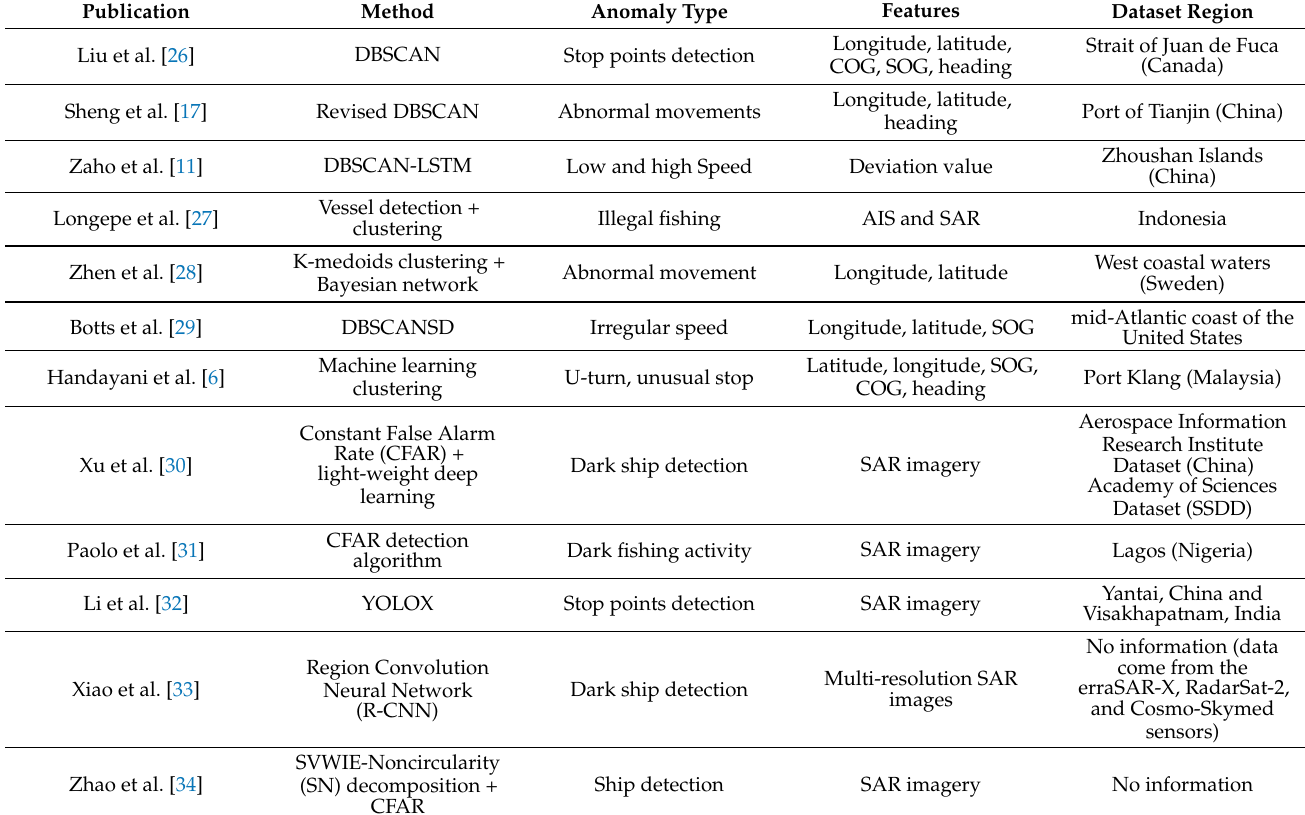
Table 1. Summary of survey results of abnormal vessel behavior